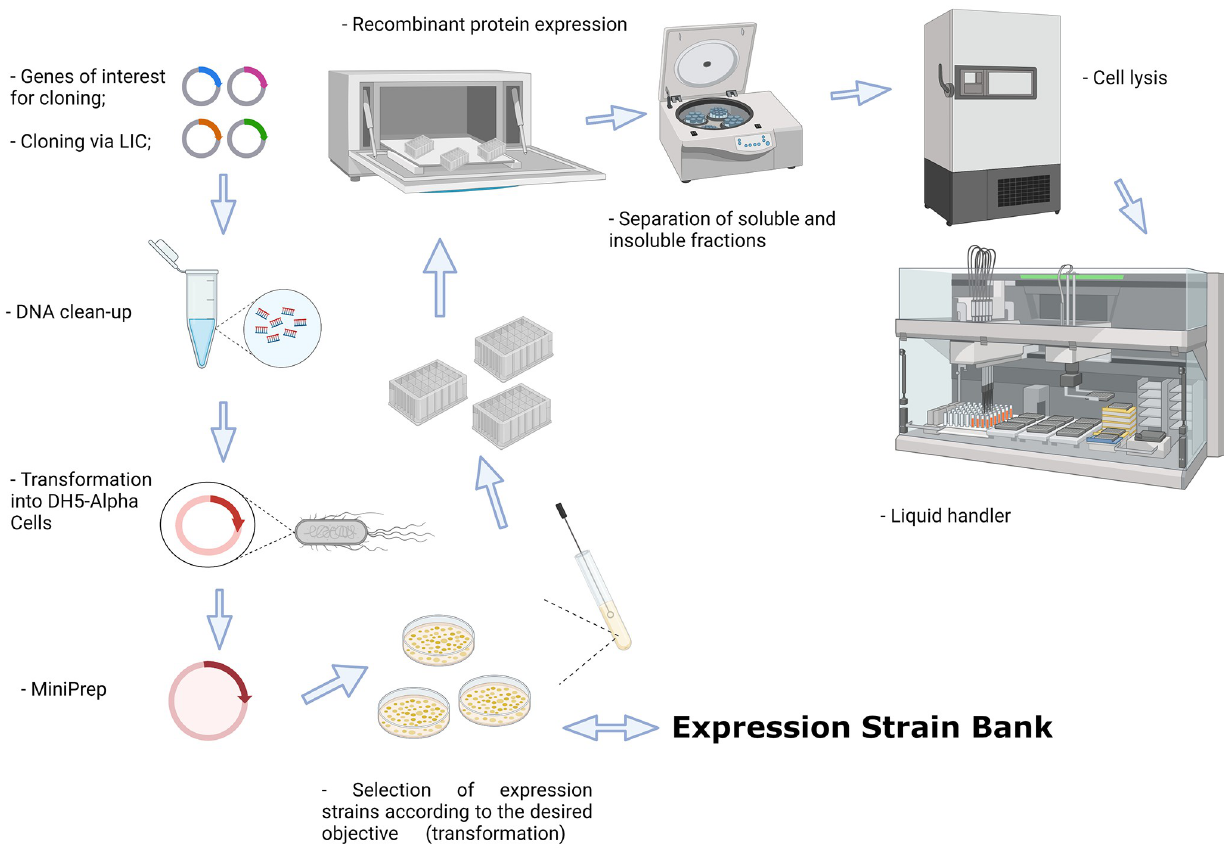
Fig 1. Overview of the pipeline used in this work. Selected genes are cloned in the pET-Trx1A/LIC vector. After plasmid propagation in E . coli DH5 α cells, the purified vector is used for transformation of a set of E . coli strains, the Expression Strain Bank. The cells are cultured in 96-well plates in auto- induction medium and, after cell lysis by freezing, a liquid handling robot separates the soluble fraction, incubates with the affinity resin, washes, and elutes the purified targets, which are further analyzed by SDS-PAGE 15%. Created with BioRender.com.